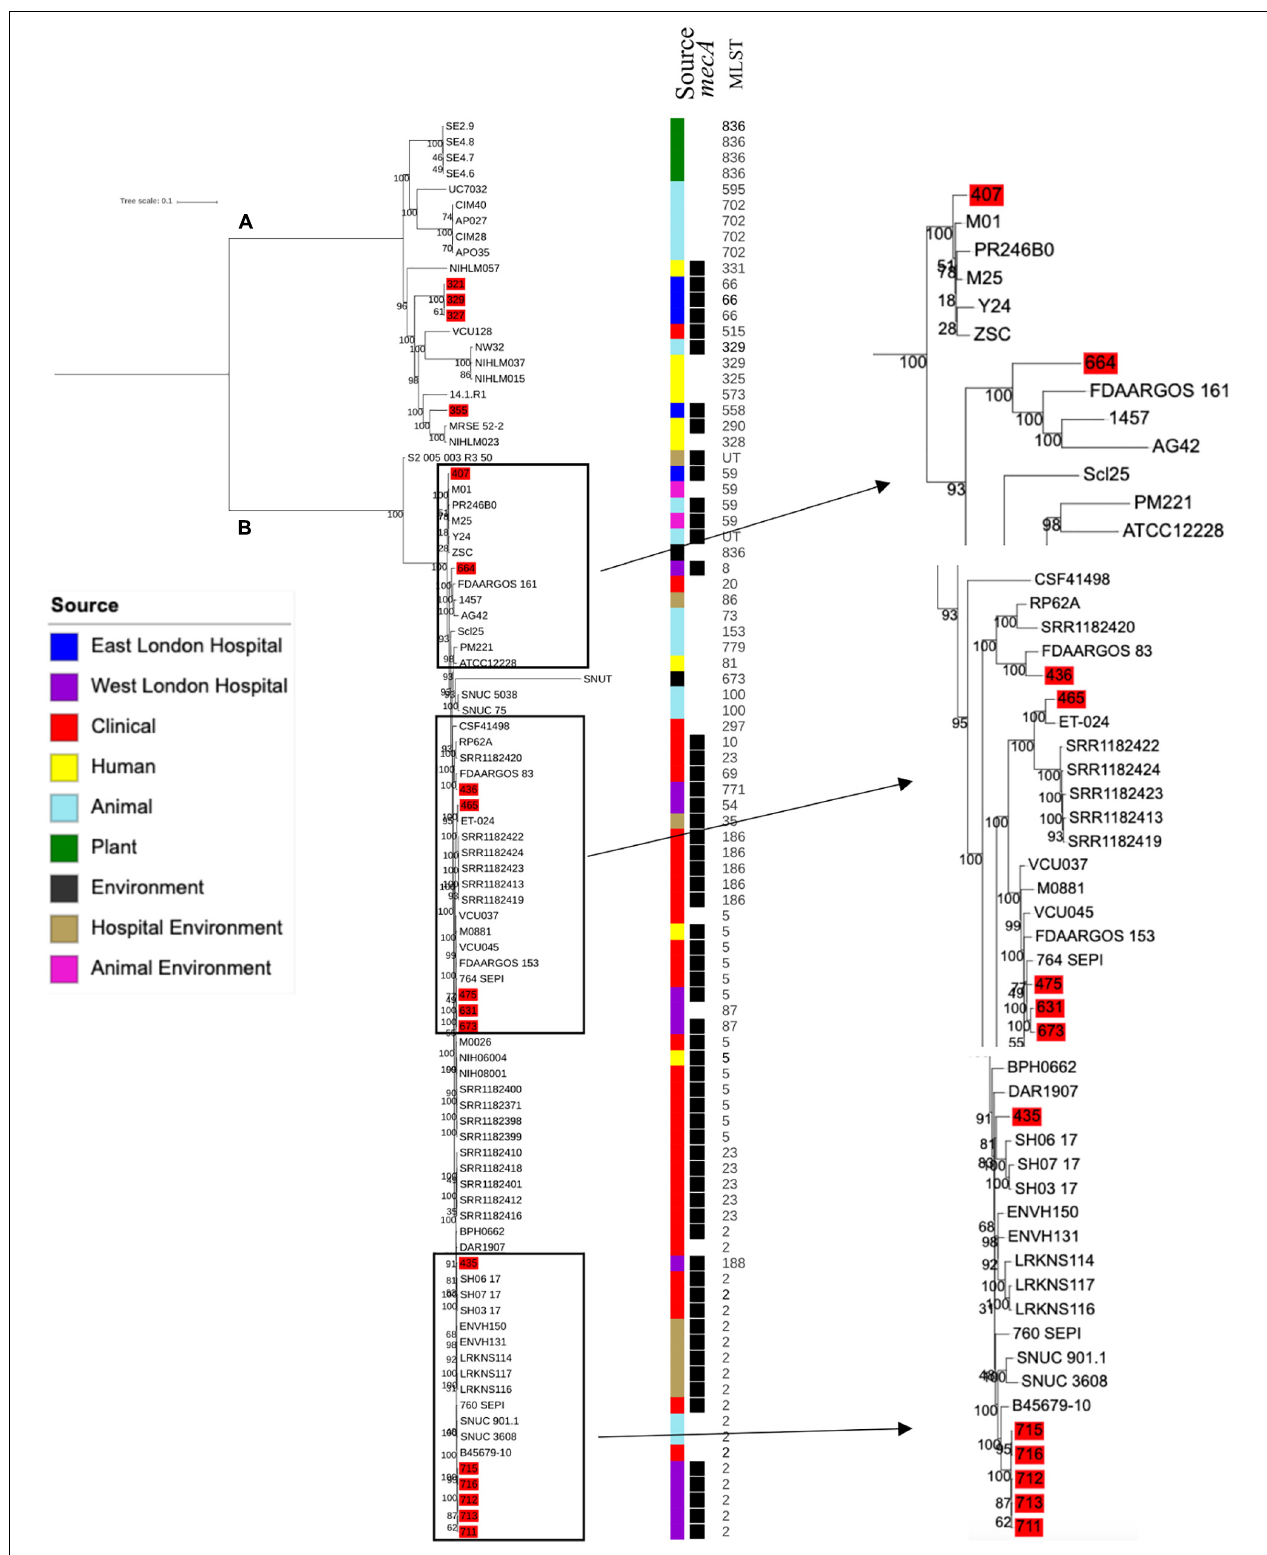
FIGURE 1 | Core SNP maximum likelihood phylogenetic tree of 90 S. epidermidis , including isolates recovered from public settings in this study and those obtained from the ENA. (A,B) represent the two most distinct clades. Isolates recovered from public settings in London are highlighted in red. MLST = sequence type, UT =